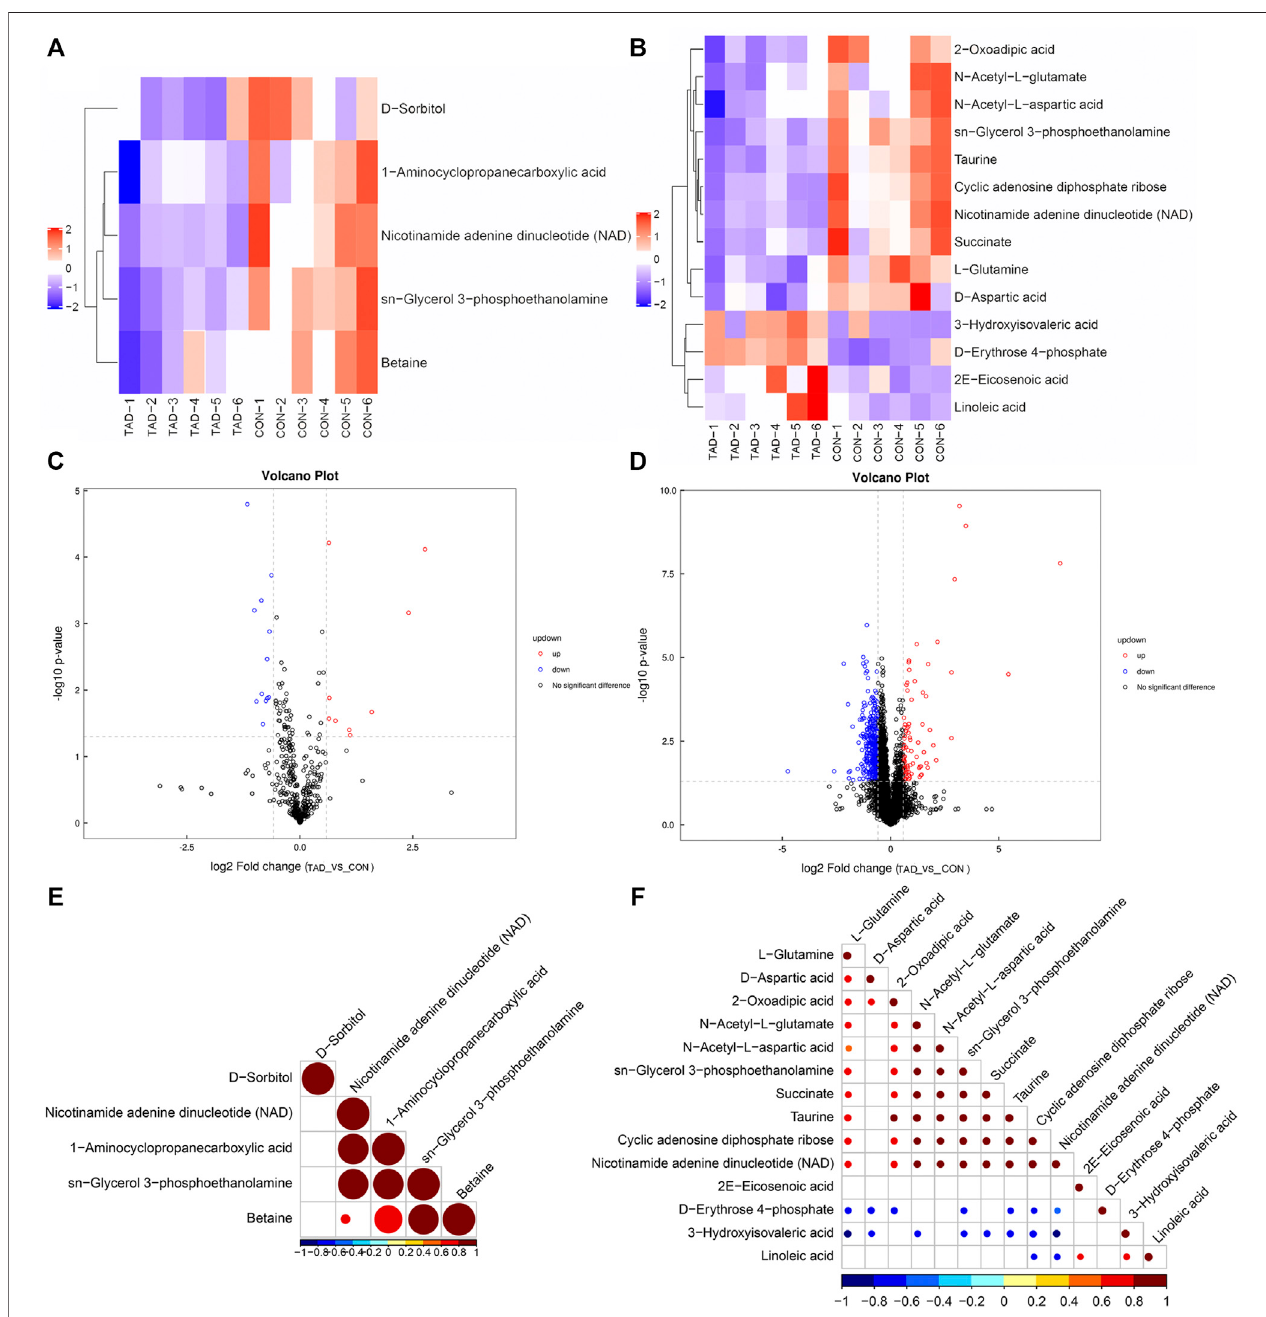
FIGURE5| MetabolicdifferencesbetweencolorectalcancerHCT116cellstreatedwithtadala fi lgroups(TAD)andwithoutgroups(CON). (A,B) Clusterheatmapof DAMs in ESI+ and ESI-. The value of DAMs expression after scale number was indicated by the blue to red color scale. (C,D) Volcano plots of DAMs in ESI+ and ESI − . Red indicates upregulated accumulated metabolites ( p -value < 0.05, FC > 1.5), and blue indicates downregulated accumulated metabolites ( p -value < 0.05, FC < 0.67). Blackindicatesnosigni fi cantdifferenceofmetabolites. (E,F) PearsoncorrelationanalysisoftheDAMsbasedon p < 0.05andVIP > 1inESI+andESI − .Thevalueof the Pearson correlation coef fi cient was represented by the color label. ESI+, electrospray ionization positive ion mode; ESI − , electrospray ionization negative ion mode; DAM, differentially accumulated metabolites.